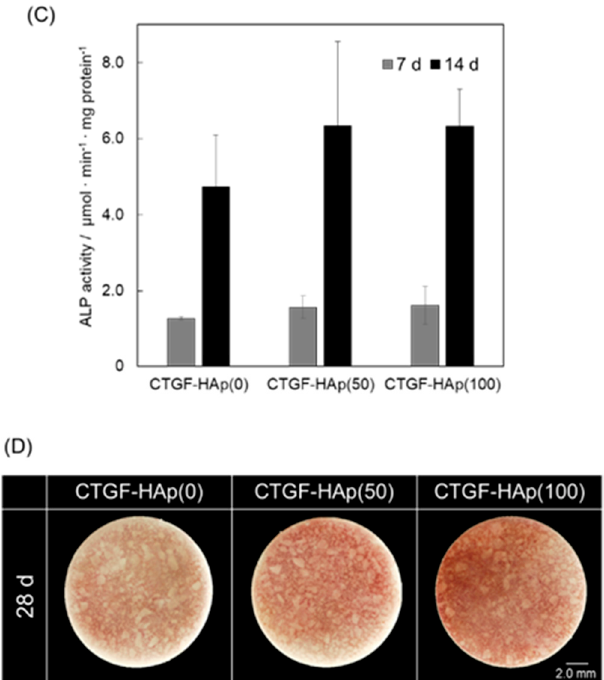
Figure 4. Comparison of osteogenic di ff erentiation between CTGF-loaded ceramics and HAp ceramics (control). ( A ) Cells on CTGF-HAp ceramics were stained for ALP levels after culturing for 14 days. Arrowheads represent cell cluster with high ALP activity. ( B ) CTGF increased ALP activity in clustered regions (Higher magnification (square in A) of MC3T3-E1 on CTGF-HAp(100) ceramics). ( C ) Comparison of ALP activity of cells at day 7 and 14 in culture. Loading CTGF increased ALP activity. Experiments were repeated three times and run in triplicate. Graphs represent means ± SD. ( D ) Cells on CTGF-HAp ceramics were cultured for 28 days, and calcium deposition was assessed by Alizarin red staining.